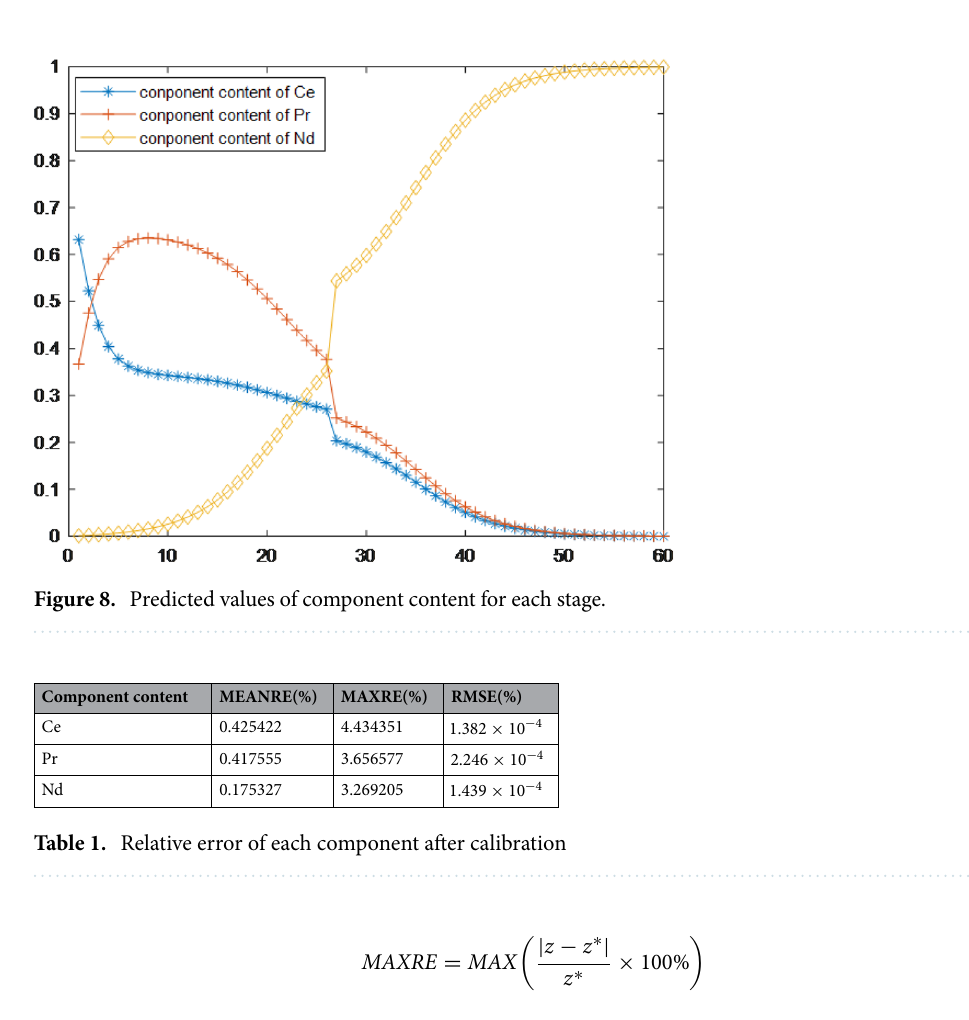
Figure 7. Relative error percentage of WLSSVM.